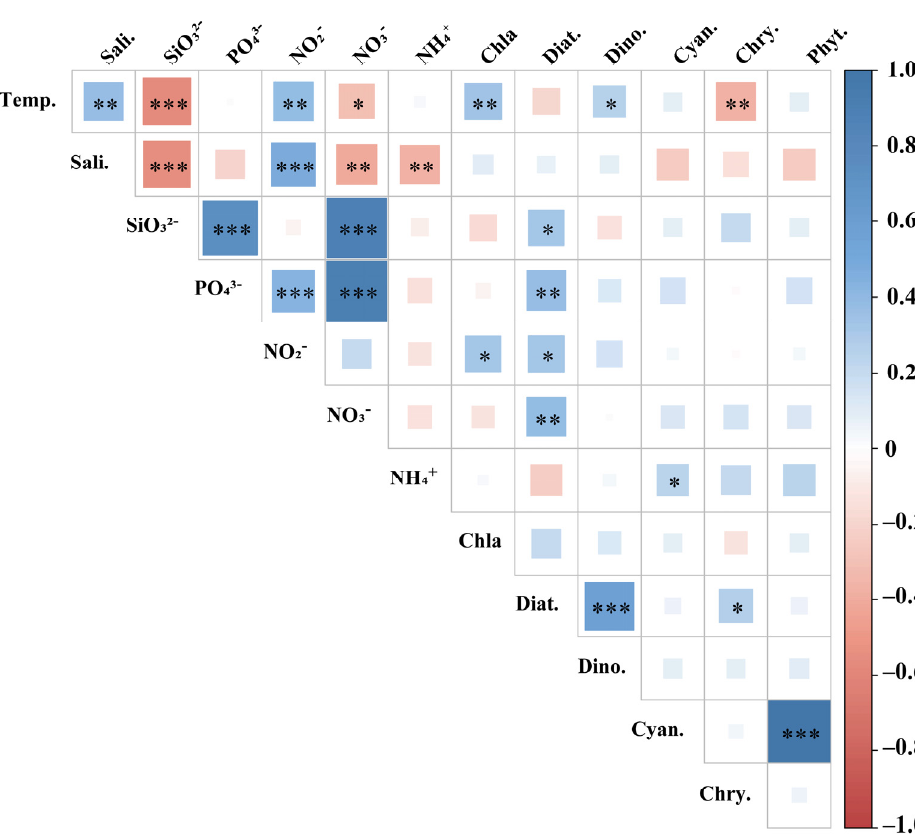
Figure 6. Pearson ′ s correlation between phytoplankton and environmental factors. Samples number: n = 63, * For p < 0.05, ** for p < 0.01, *** for p < 0.001. Temp.: temperature; Sali.: salinity; Diat.: Diatom; Dino.: Dinoflagellate; Cyan.: Cyanobacteria; Chry.: Chrysophyceae; NO 3– : nitrate; NO 2– : nitrite, NH 4 + : ammonium, PO 43– : phosphate, and SiO 32– : silicate.